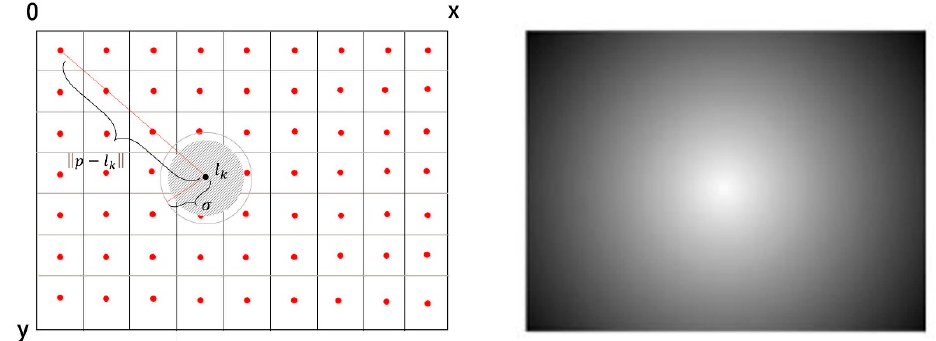
Figure 2. Gaussian kernel function distribution